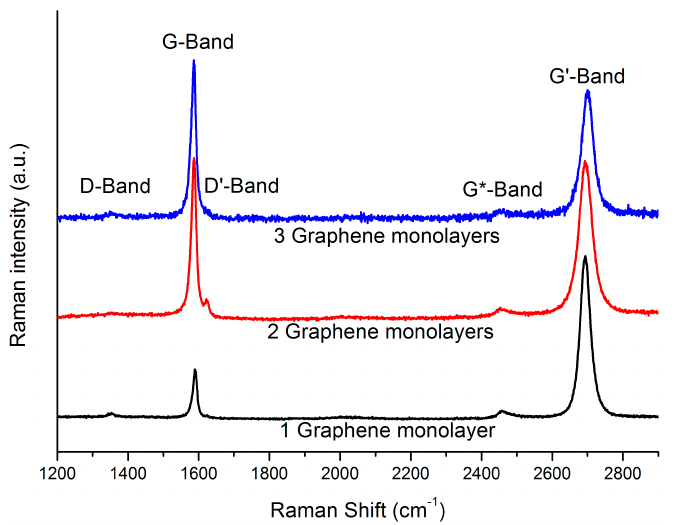
Figure 2. Raman spectra of the graphene layers transferred onto the ITO. The I G / I G’ ratio of the monolayer, bi-layer and tri-layer samples lies within the expected range, indicating a successful layer-by-layer transfer process.